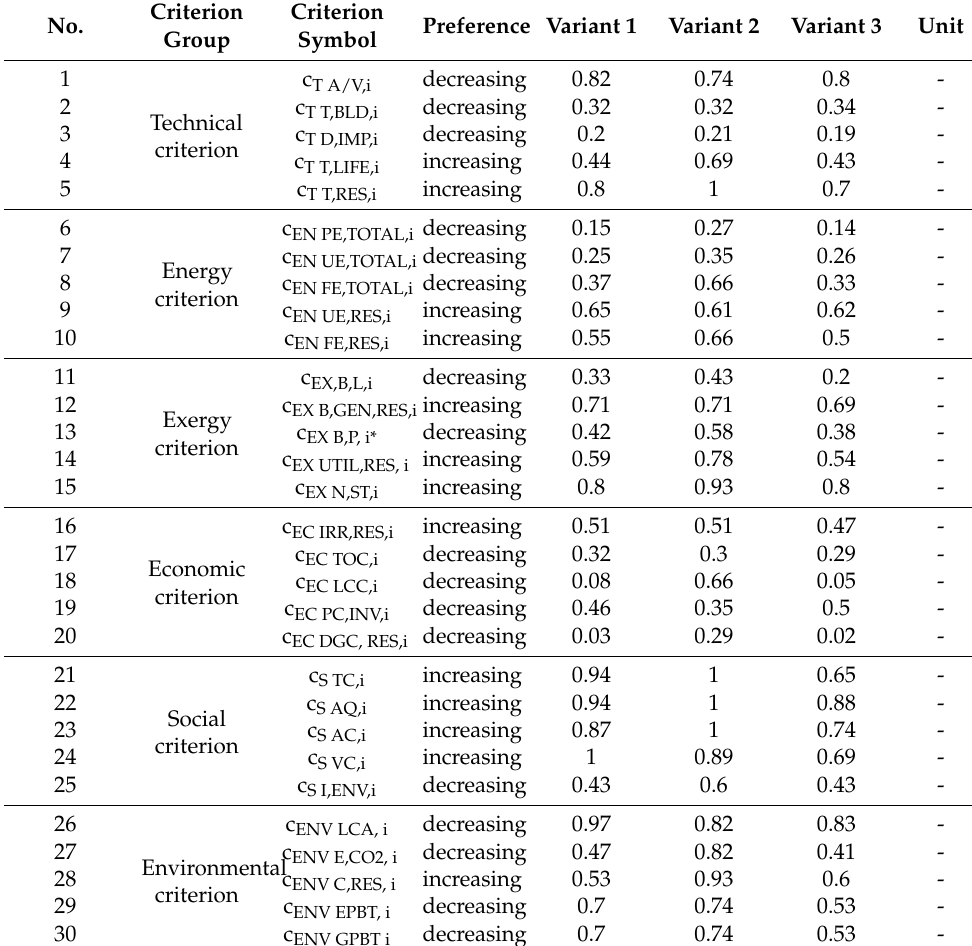
Table 9. Normalized values of indicators for selected evaluation